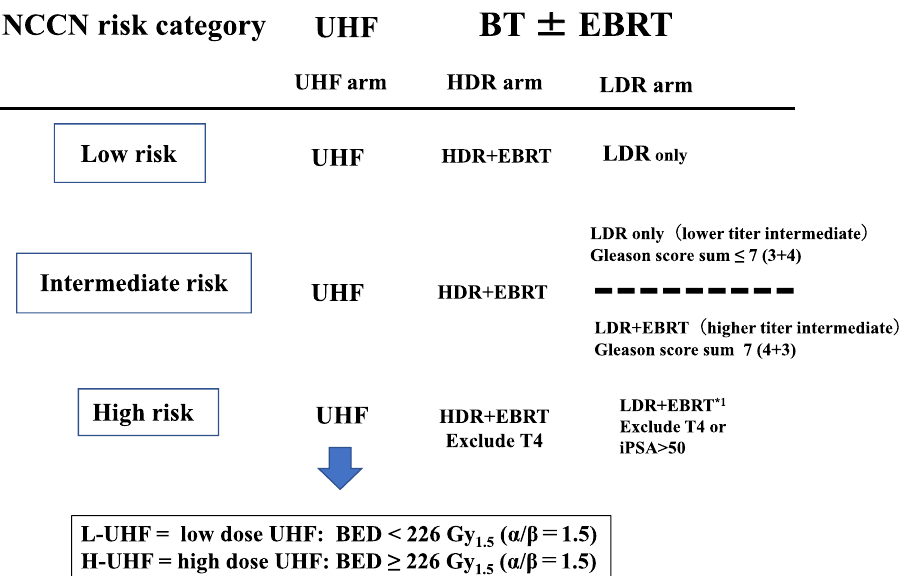
Figure 1. Scheme of treatments according to National Comprehensive Cancer Network (NCCN) risk classification. Abbreviations; BT brachytherapy, HDR high-dose-rate, LDR low-dose-rate, EBRT external